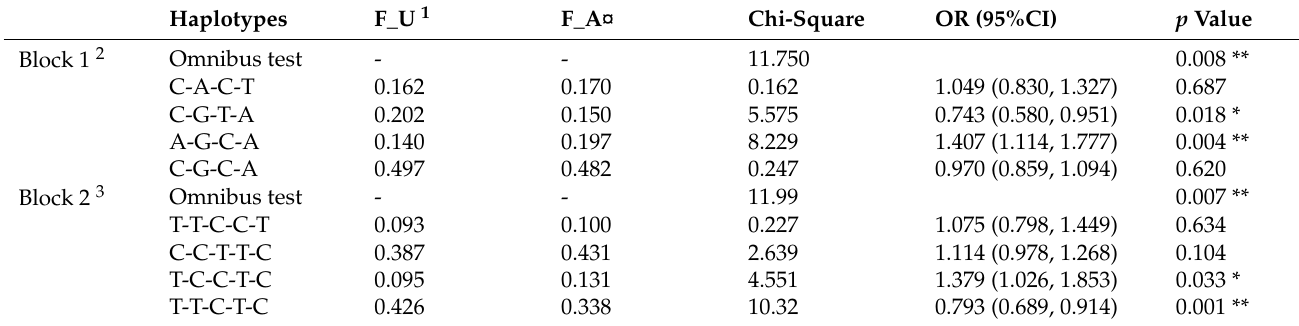
Table 3. Haplotype analysis for blocks in AGER and IL6R genes.